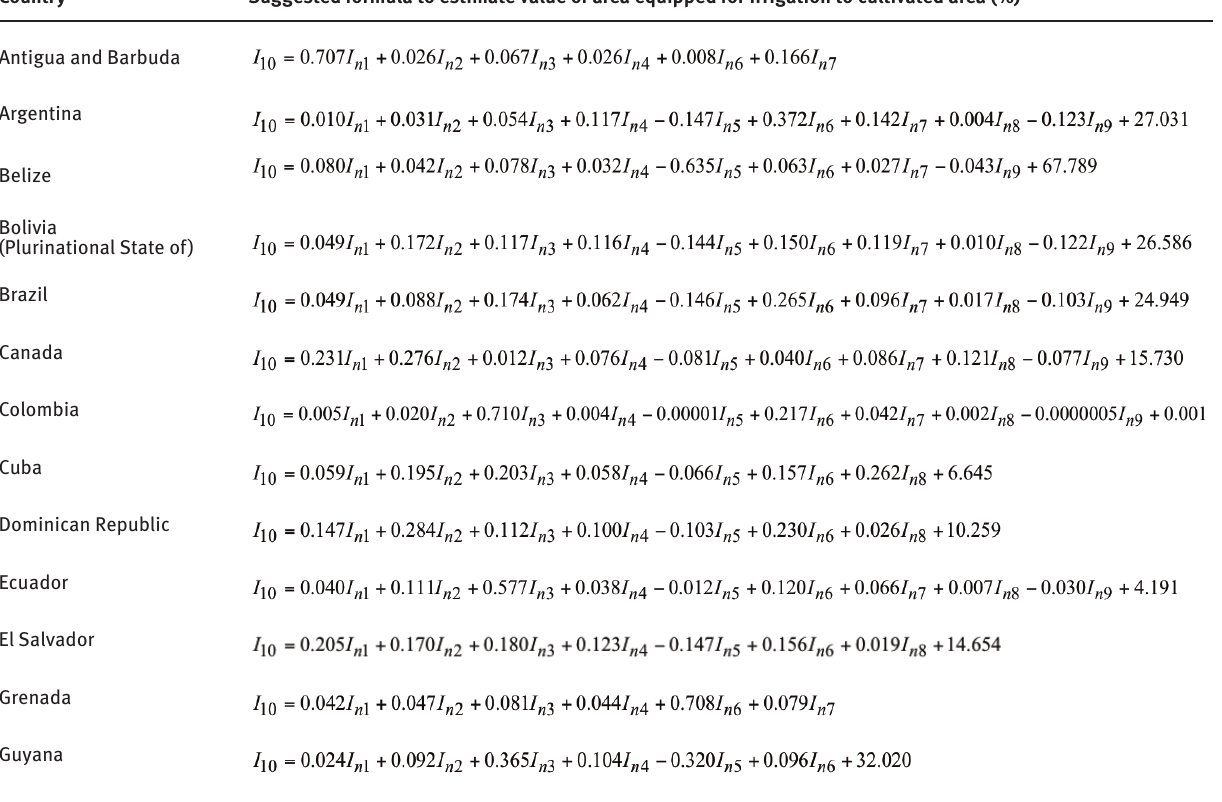
Country Suggested formula to estimate value of area equipped for irrigation to cultivated area